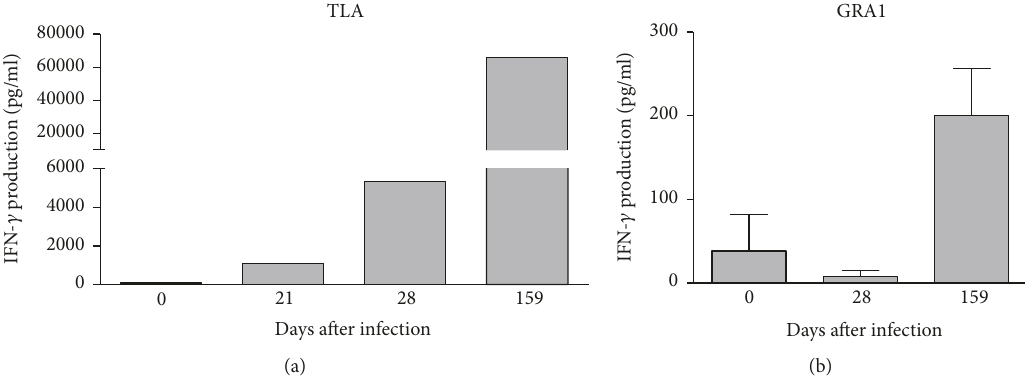
Figure 4: IFN- γ production by T. gondii -speci fi c T cells. 1.5 × 10 5 peripheral blood mononuclear cells from infected animals were stimulated with TLA (a) or GRA1 (b) for fi ve days. Thereafter, supernatants were harvested and the IFN- γ concentration was determined by ELISA. Data are given as mean ± SD from two experiments, performed in duplicate (a) or as mean ± SD from four experiments, performed in duplicate